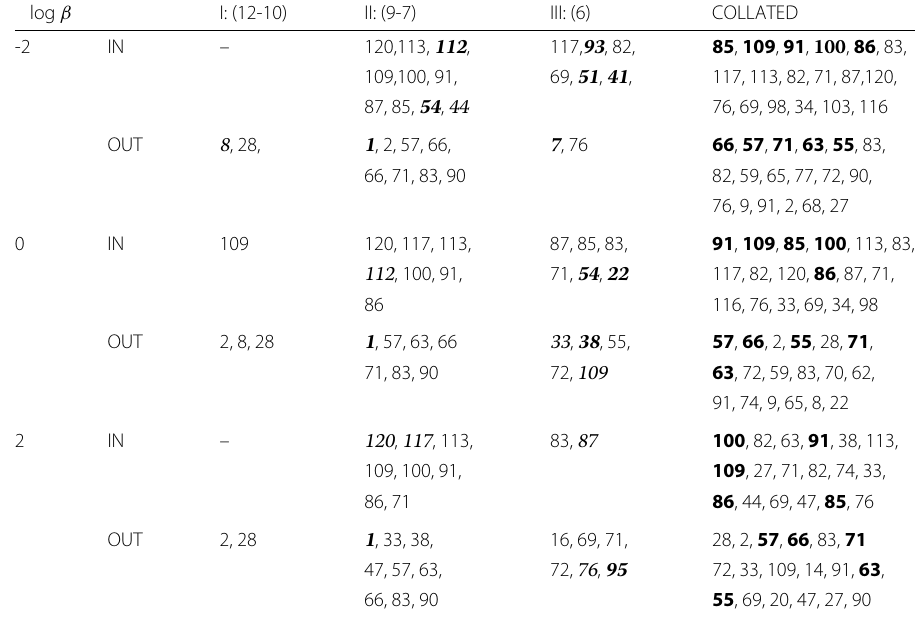
Table 4 Key concepts as they appear in the collated and 12 individual concept